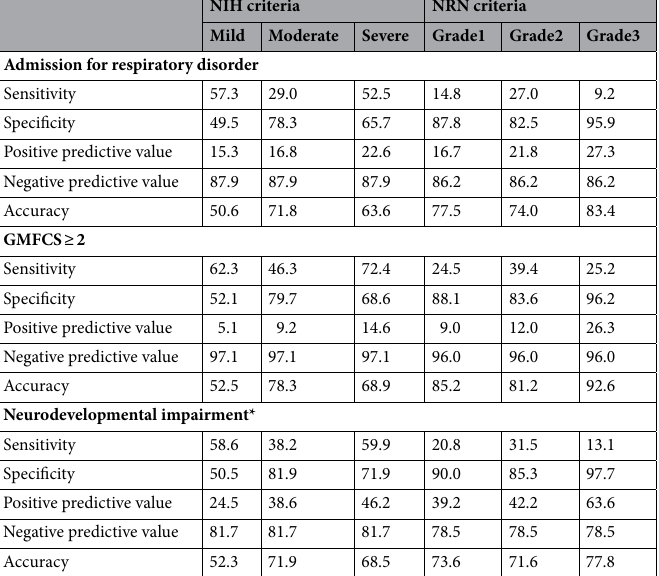
Table 4. Predictive values of BPD for admission for respiratory disorder, GMFCS score, and neurodevelopmental impairment at a corrected age of 18–24 months. The predictive values of BPD were calculated using “no BPD” as a reference. BPD bronchopulmonary dysplasia, GMFCS Gross Motor Function Classification System. *NDI (neurodevelopmental impairment) defined as Bayley composite score < 70(II) or < 85(III) or K-DST < -2 standard